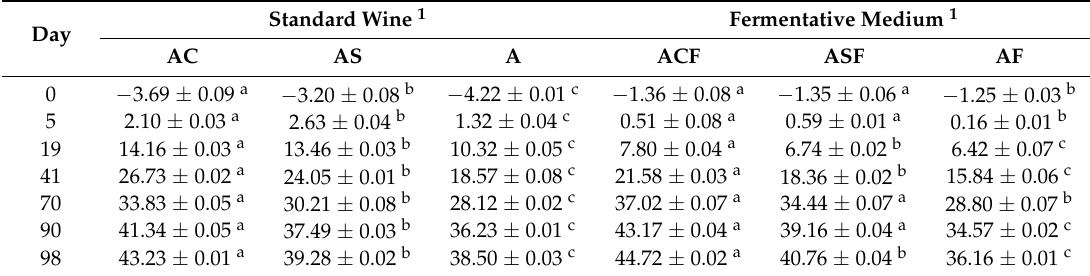
Table 3. Evolution of the mean value of hue (h ab ) in the model systems.